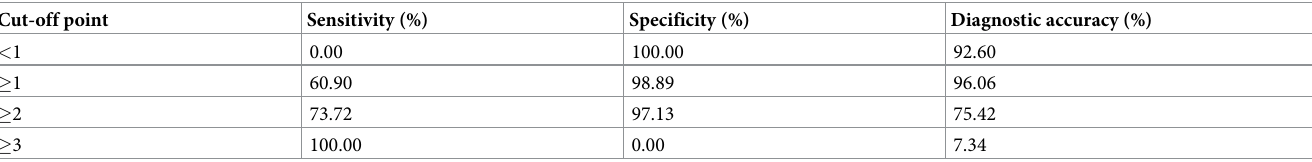
Table 3. Sensitivity, specificity, and diagnostic